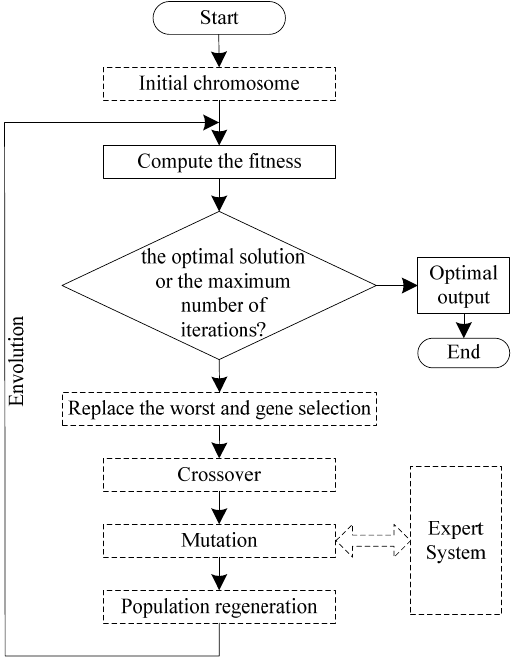
Figure 3. Flowchart of the improved genetic algorithm.